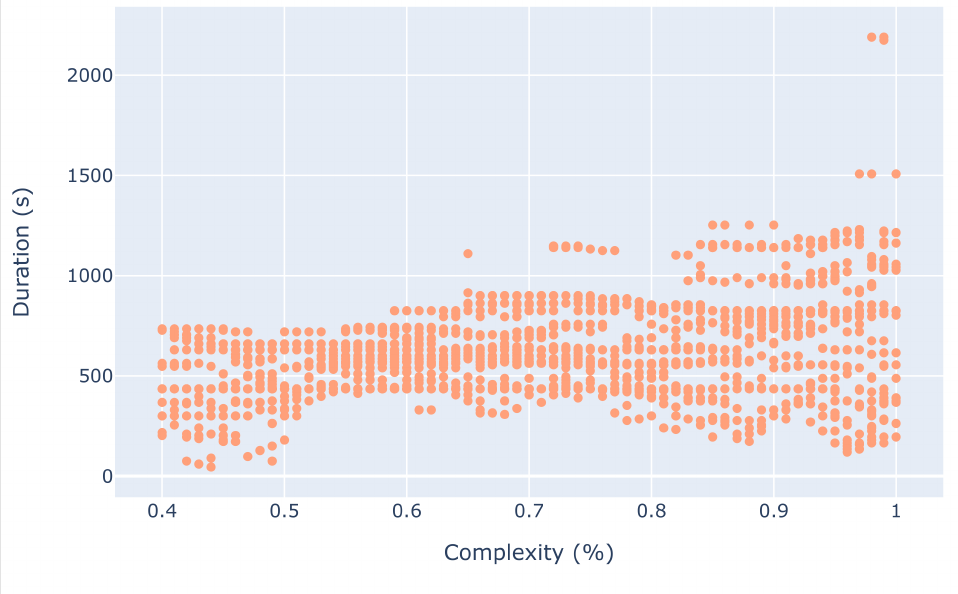
Figure 30. Duration of communities for different complexity thresholds (distance threshold > 25